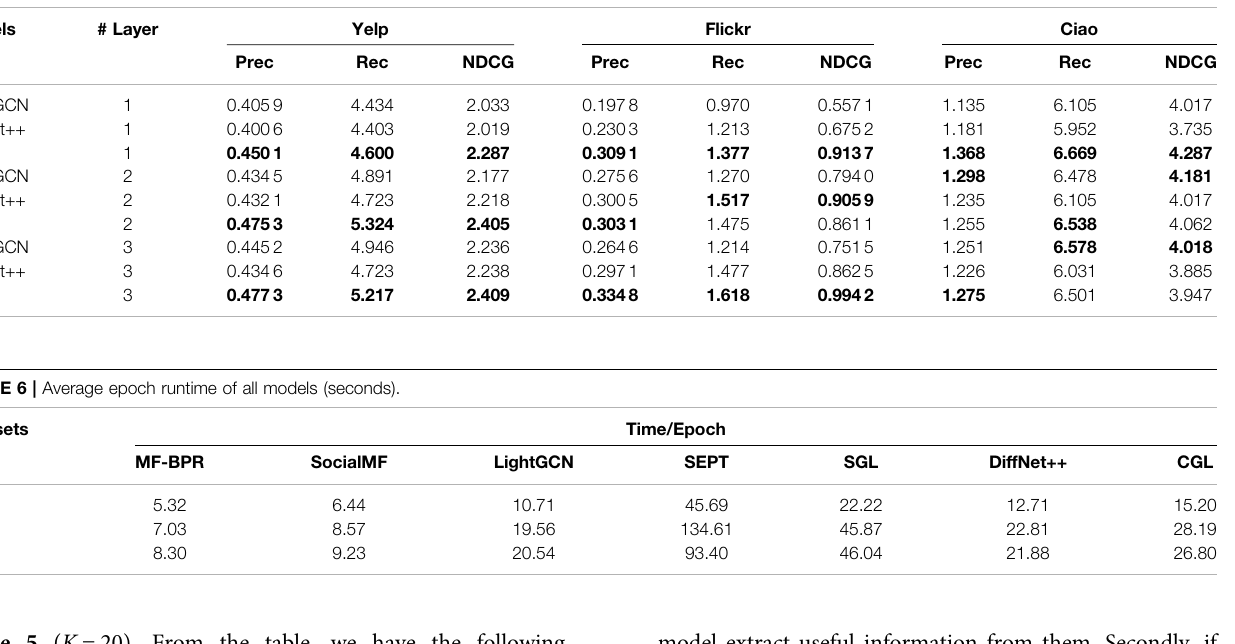
Table 5 ( K = 20). From the table, we have the following